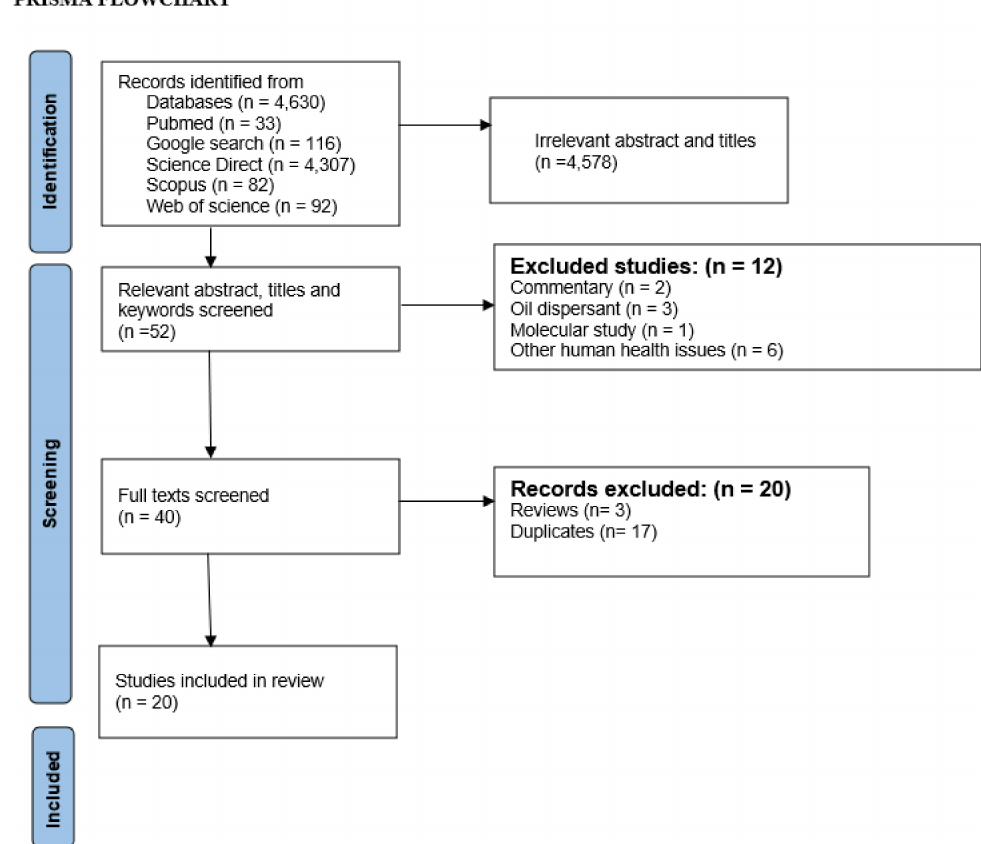
Figure 1. Study selection process using PRISMA